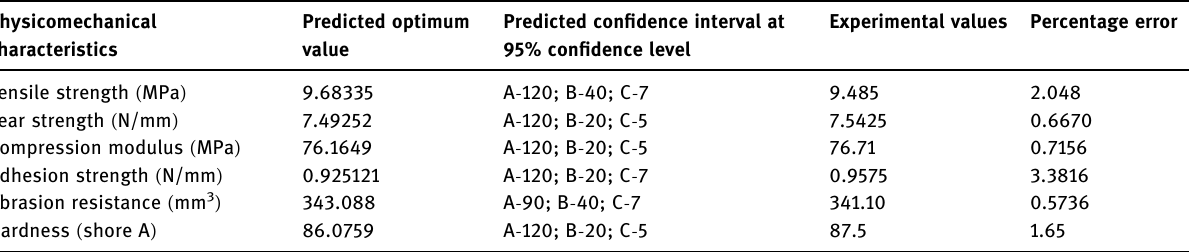
Table 19: Results of a con fi rmatory experiment for tensile strength, tear strength, compression modulus, adhesion strength, abrasion resistance, and